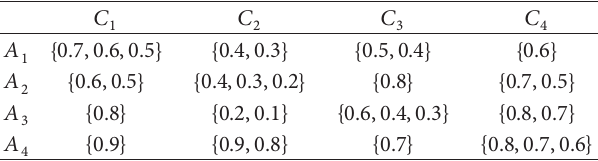
Table 1: The hesitant fuzzy decision matrix R 1 provided by decision maker 𝐷 1 .